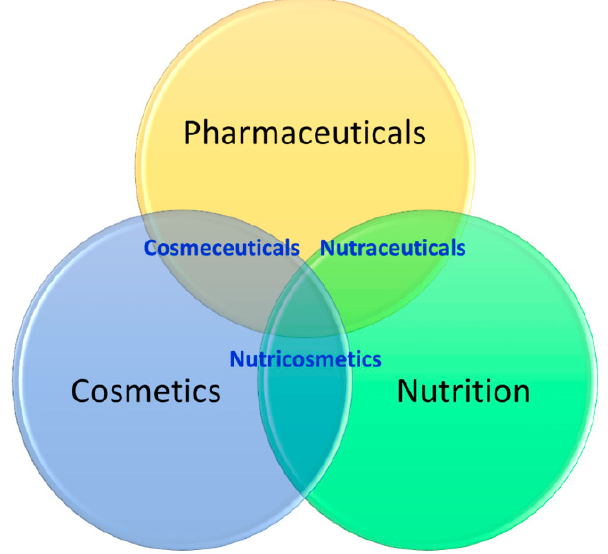
Figure 2. Wide-scale applications of mushrooms including Ganoderma lucidum ; i.e., pharmaceuticals, nutraceuticals, and cosmetics. Source: Reprinted from Wu et al. [31]. Licensed under CC BY 4.0. Table 1. Some of the cosmetic products are produced commercially from the G . lucidum mushroom worldwide *.